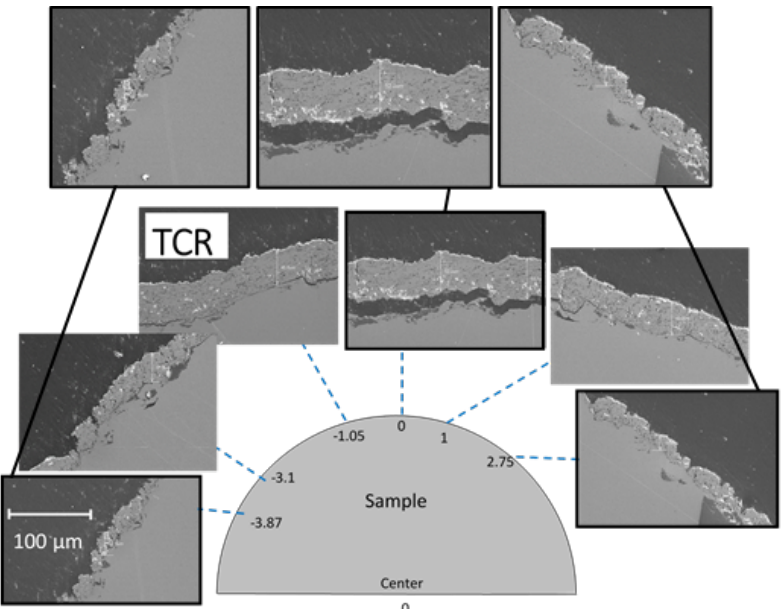
Figure 13. Metallographic SEM images of the coating cross-section deposited on the rod coarse grit-blasted substrate (TCR) and recorded at di ff erent locations along the substrate surface.